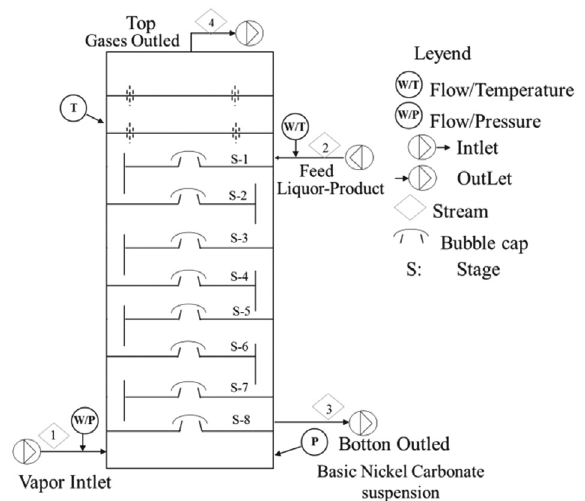
Figure 2. Steam-stripped